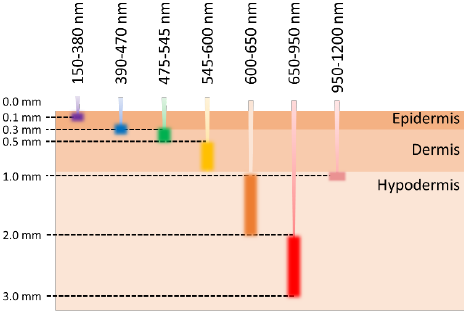
Figure 1. The relationship between light wavelengths and penetration depths.